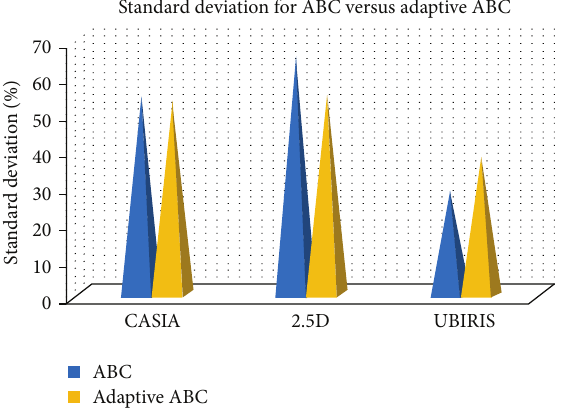
Figure 6: Standard deviation taken by conventional and adaptive ABC algorithm for the three datasets.